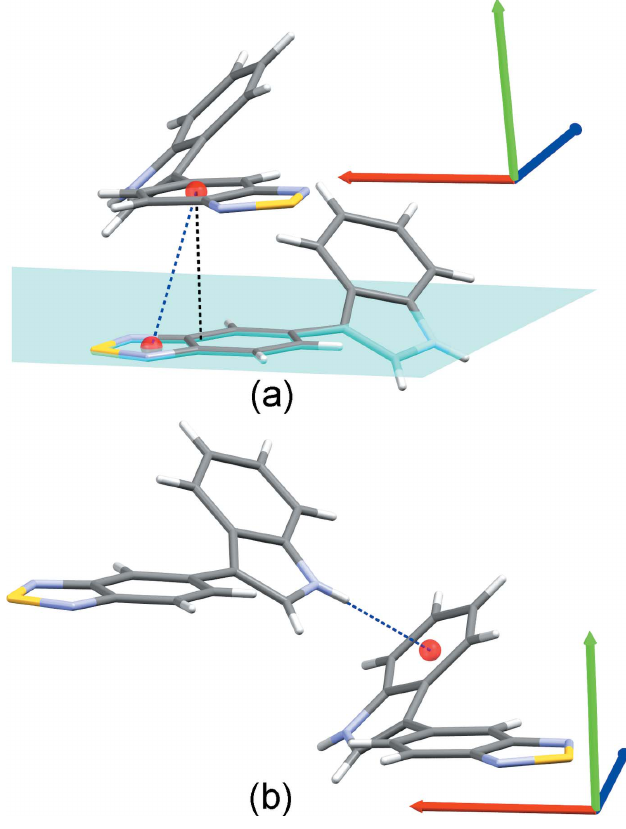
Figure 5 Supramolecular organization of bS. ( a ) (cid:2) -stacking interaction between the benzothiadiazole groups and ( b ) N—H (cid:6)(cid:6)(cid:6) (cid:2) interaction between two indole